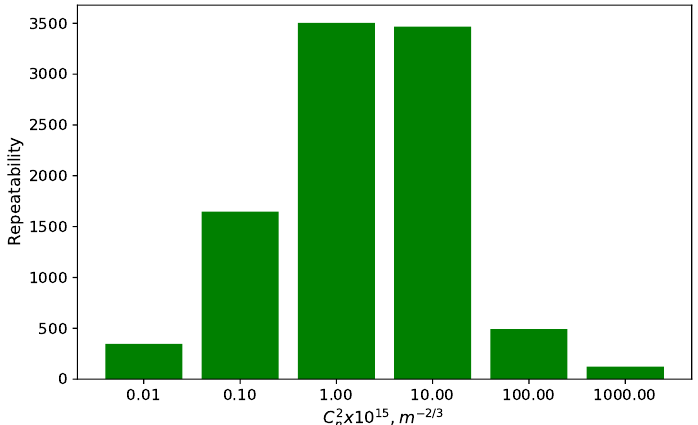
Figure 3. The repeatability of the optical turbulence at the Baykal astrophysical observatory site in summer.